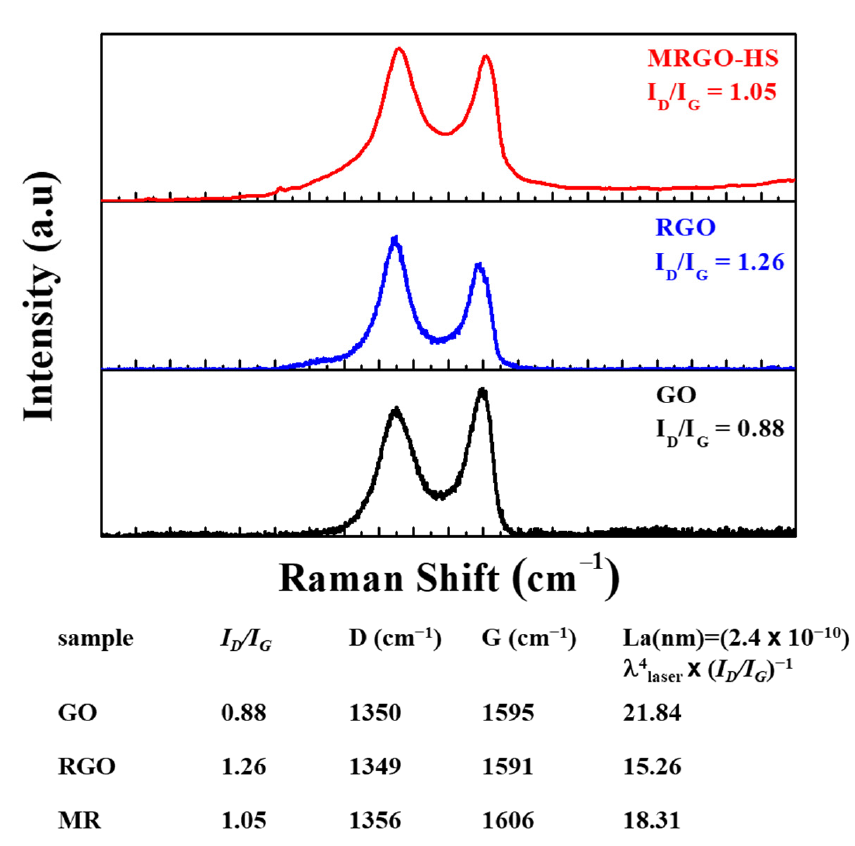
Figure 7. The Raman spectra of GO, RGO, and MRGO-HS.